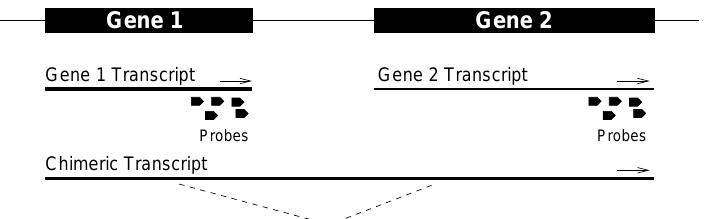
Figure 6: Hypothetical probes mapping in the 3 (cid:48) region of the transcripts. The arrows show the direction of transcription. The dotted line shows where the chimeric might be spliced from the penultimate exon of Gene 1 and second exon of